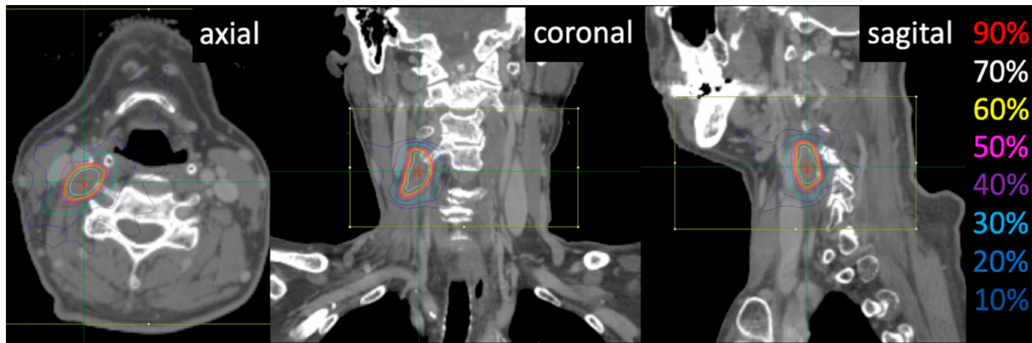
Figure 3. Dose distribution for CyberKnife in a representative case. A 58-year-old man with oropharyngeal cancer underwent radiotherapy with 60 Gy in 30 fractions. He showed neck lymph node recurrence after 12 months. He then received 30 Gy in 3 fractions by CyberKnife treatment. He is alive 20 months after CyberKnife treatment. Colored lines show 90% (red), 70% (white), 60% (yellow),